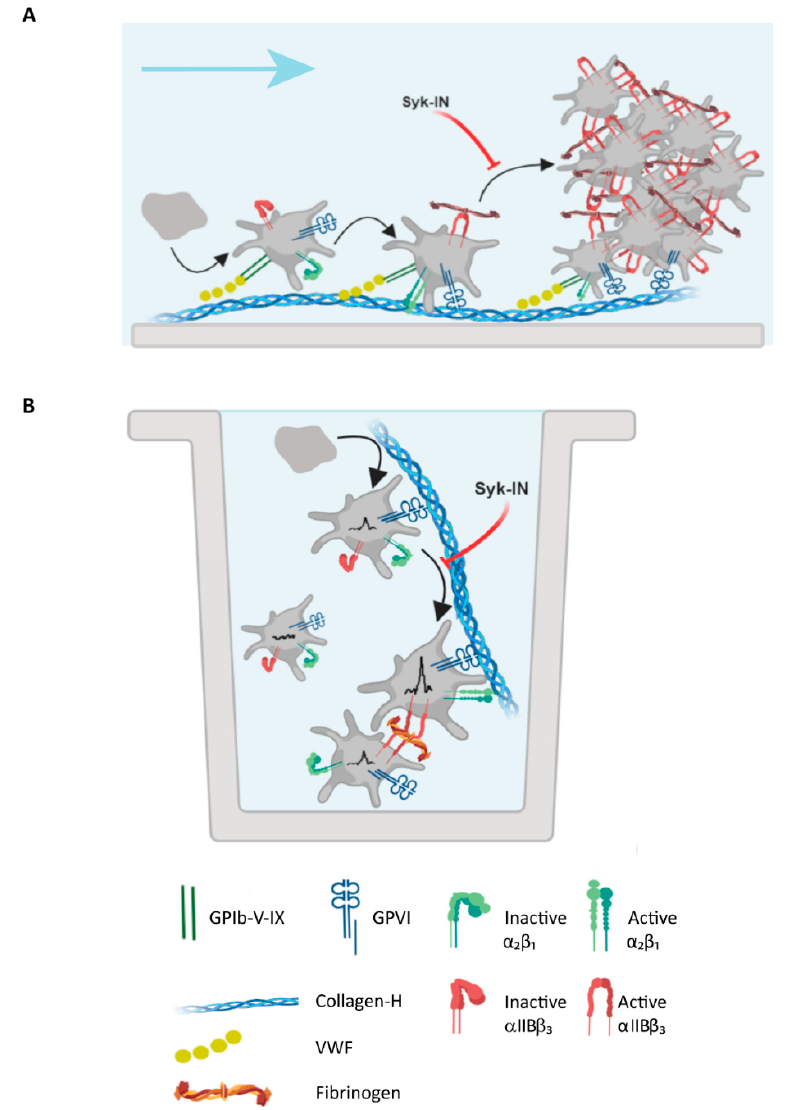
Figure 7. Schematic platelet adhesion and activation by collagen under flow or in suspension. ( A ) Under flow conditions, immobilized collagen-H interacted with VWF to capture platelets via GPIb-V-IX and activate platelets via GPVI and integrin α 2 β 1 . Thrombi built up through the recruitment of flowing platelets interacting with collagen / VWF-adhered platelets. Syk inhibition suppressed initial platelet activation and platelet aggregate formation. ( B ) Collagen-H added to a suspension of platelets transiently interacted with GPVI, resulting in Syk-dependent Ca 2 + rises. Autocrine agonists stimulated non-adhered platelets, responding through Syk-independent signals.